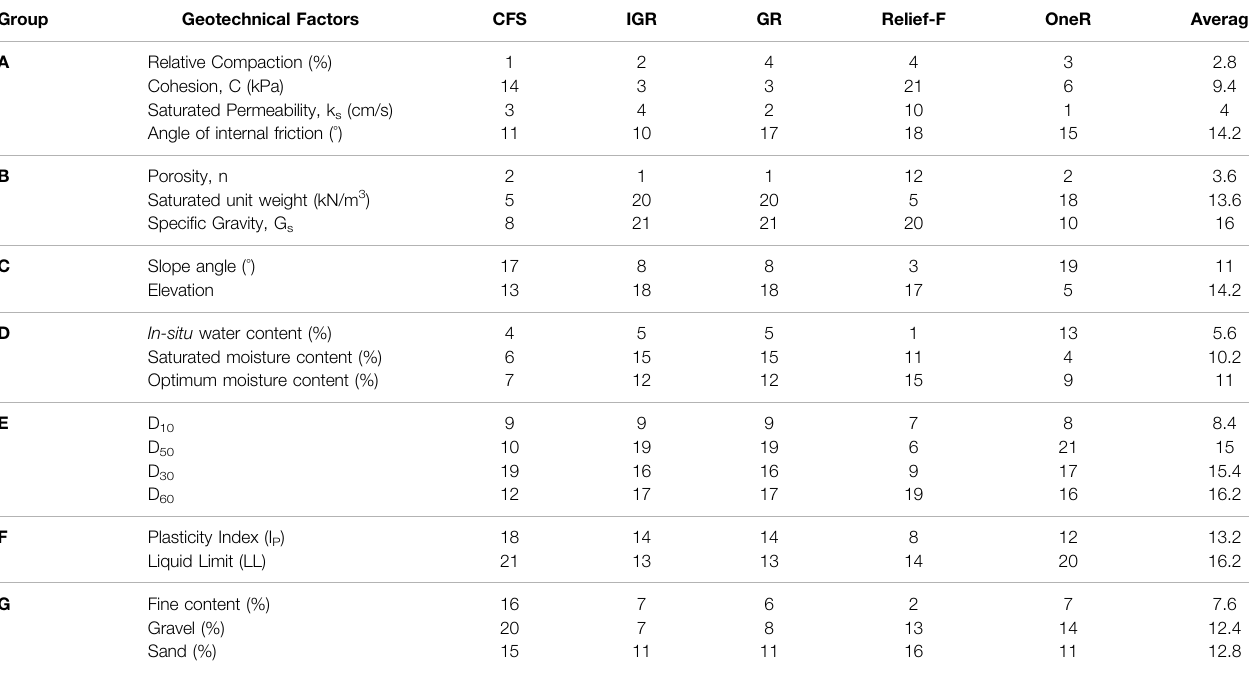
TABLE 8 | Ranking of different geotechnical factors using different feature selection